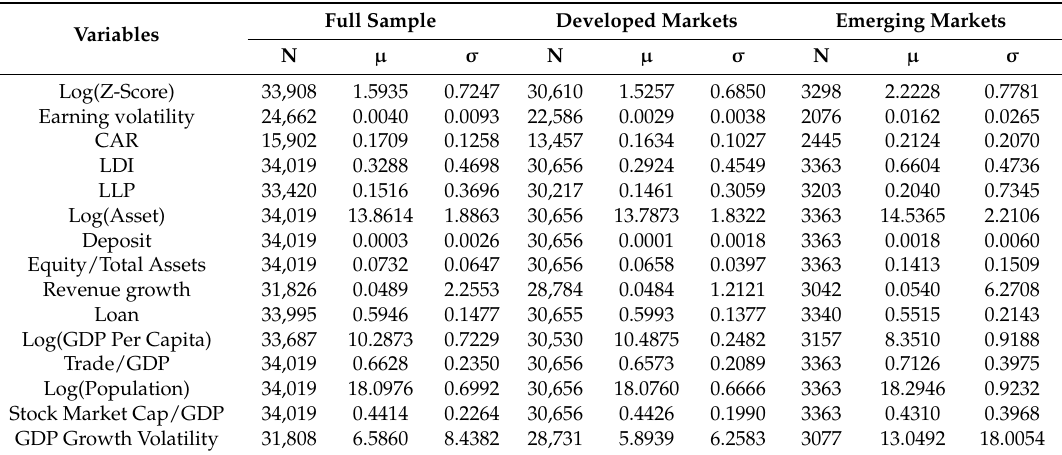
Table 2. Descriptive